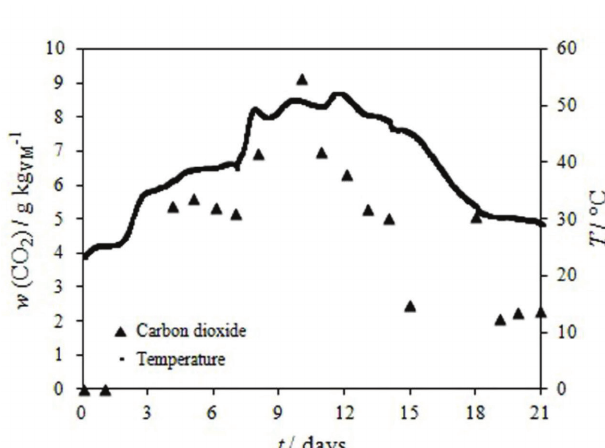
Fig. 5 – Evolution of ammonia versus pH values during com- posting of mixture of GW, OW and